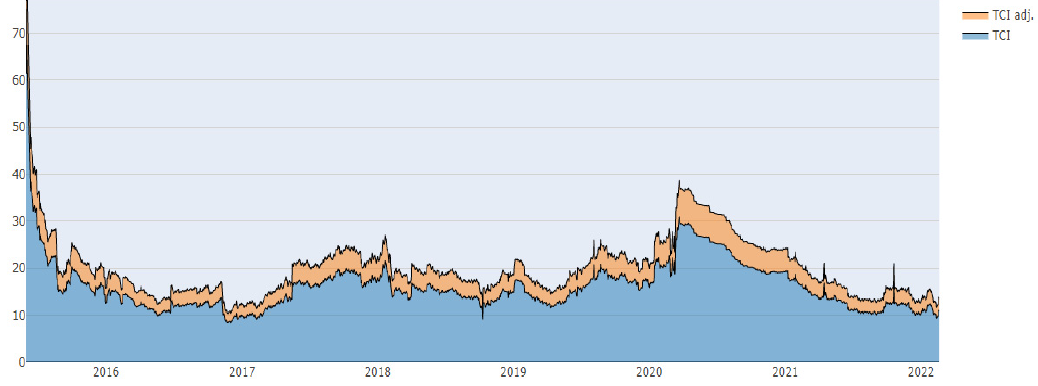
Figure 4. Net pairwise directional connectedness (NPDCI).